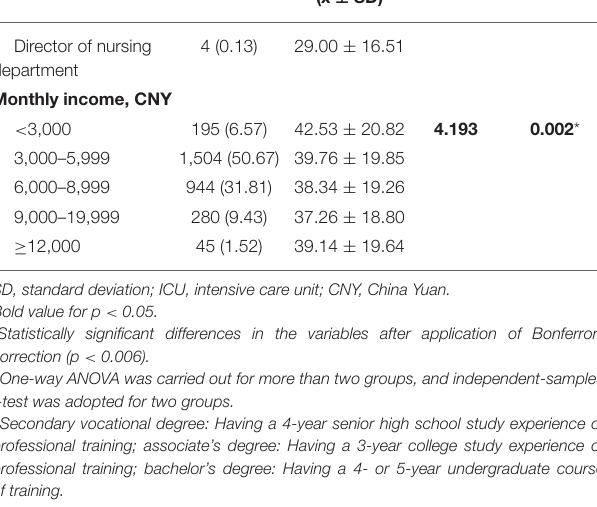
TABLE 2 | Respondent characteristics and univariate analysis of demographic factors related to job burnout in nurses.